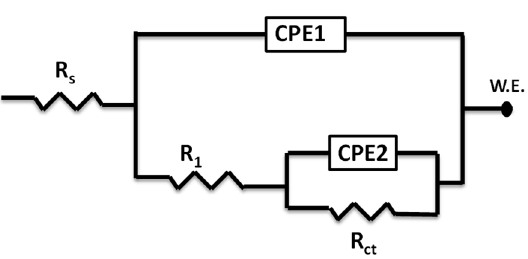
Figure 4. An equivalent electric circuit for EIS measured data analysis.